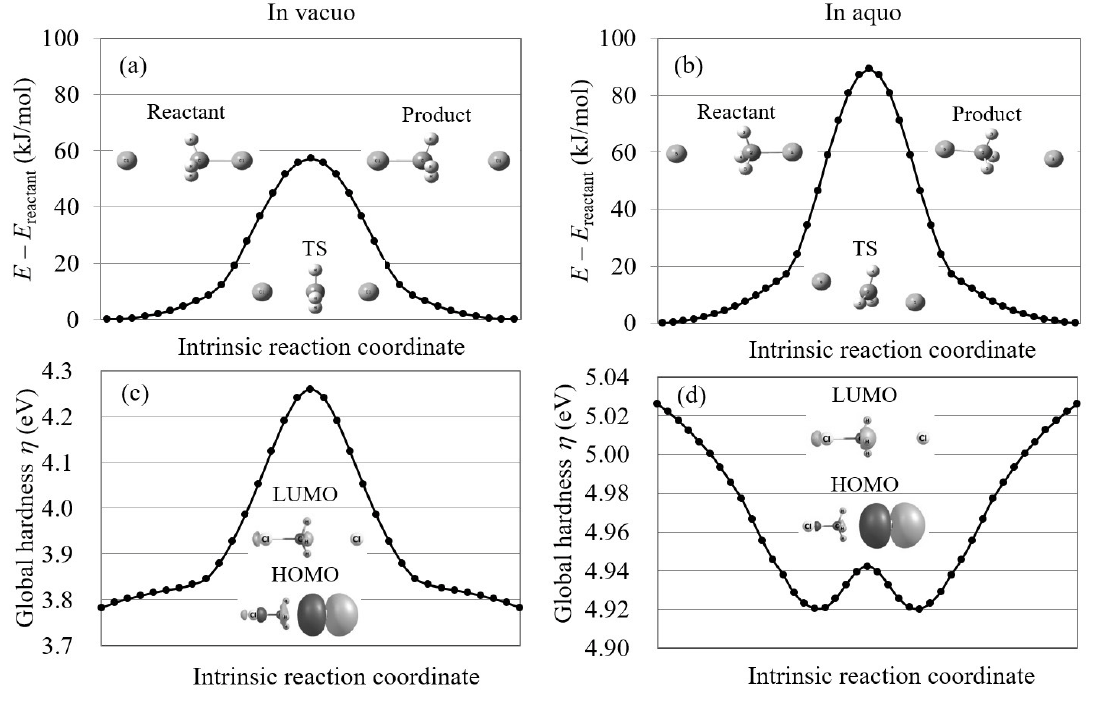
Figure 7. The potential energy curves and the global hardnesses of the Cl − ...CH 3 Cl → ClCH 3 ...Cl − reaction in gas phase and in aqueous solution on their intrinsic reaction coordinates, which are calculated by LC-BLYP/aug-cc-pVTZ. The images of the molecular orbitals mainly contributing to each reaction process are also